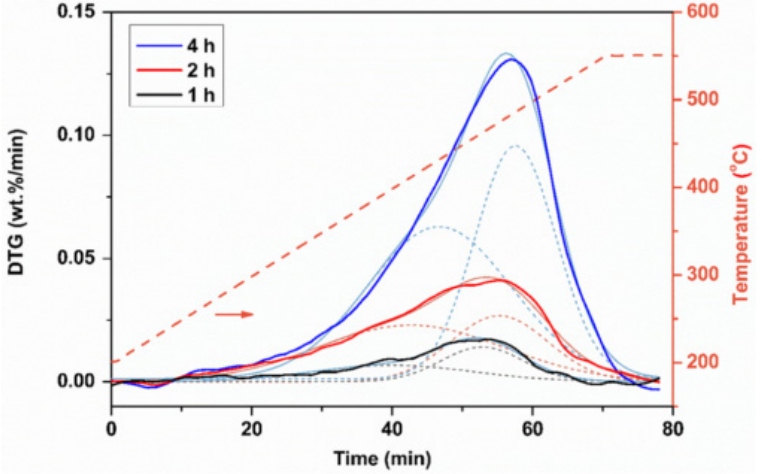
Figure 20. TPO curves and deconvoluted peaks of Y-zeolite coked during catalytic pyrolysis of PE at different TOS. Chen et al. [65].